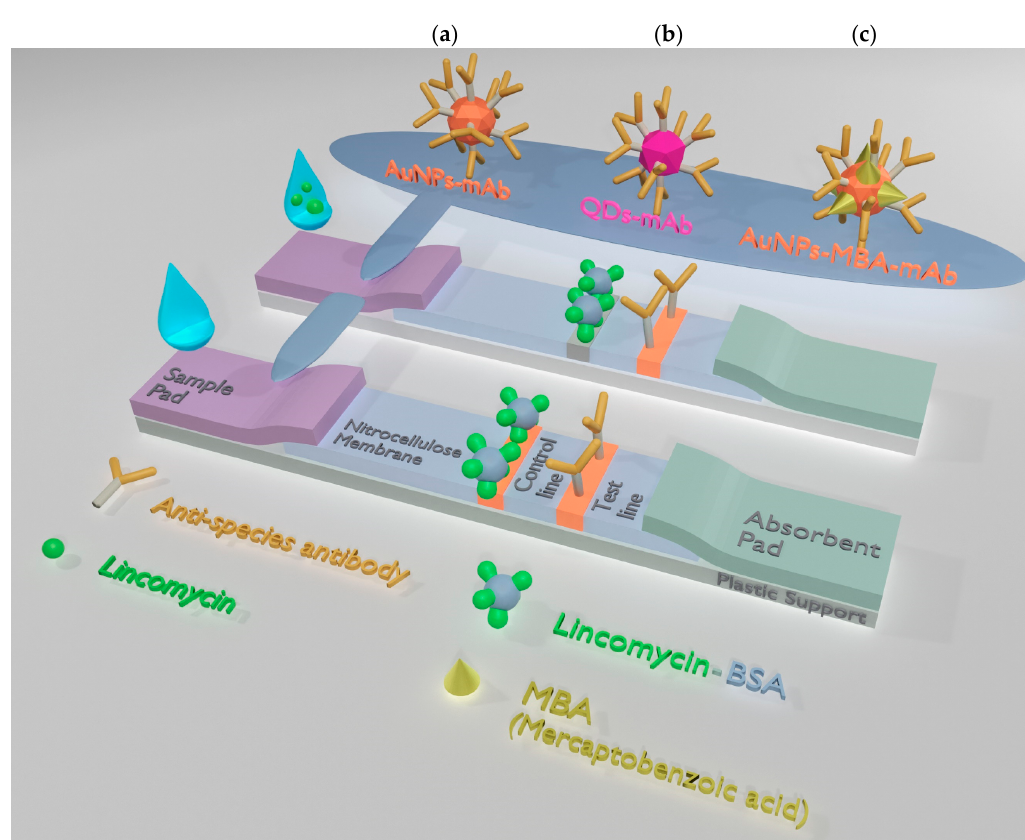
Figure 1. Schemes of lateral flow immunoassay (LFIA) formats developed in the study: conventional colorimetric gold nanoparticle (AuNP)-based LFIA ( a ); fluorescent quantum dot (QD)-based LFIA ( b ); AuNP-based LFIA with surface-enhanced Raman scattering (SERS) detection ( c